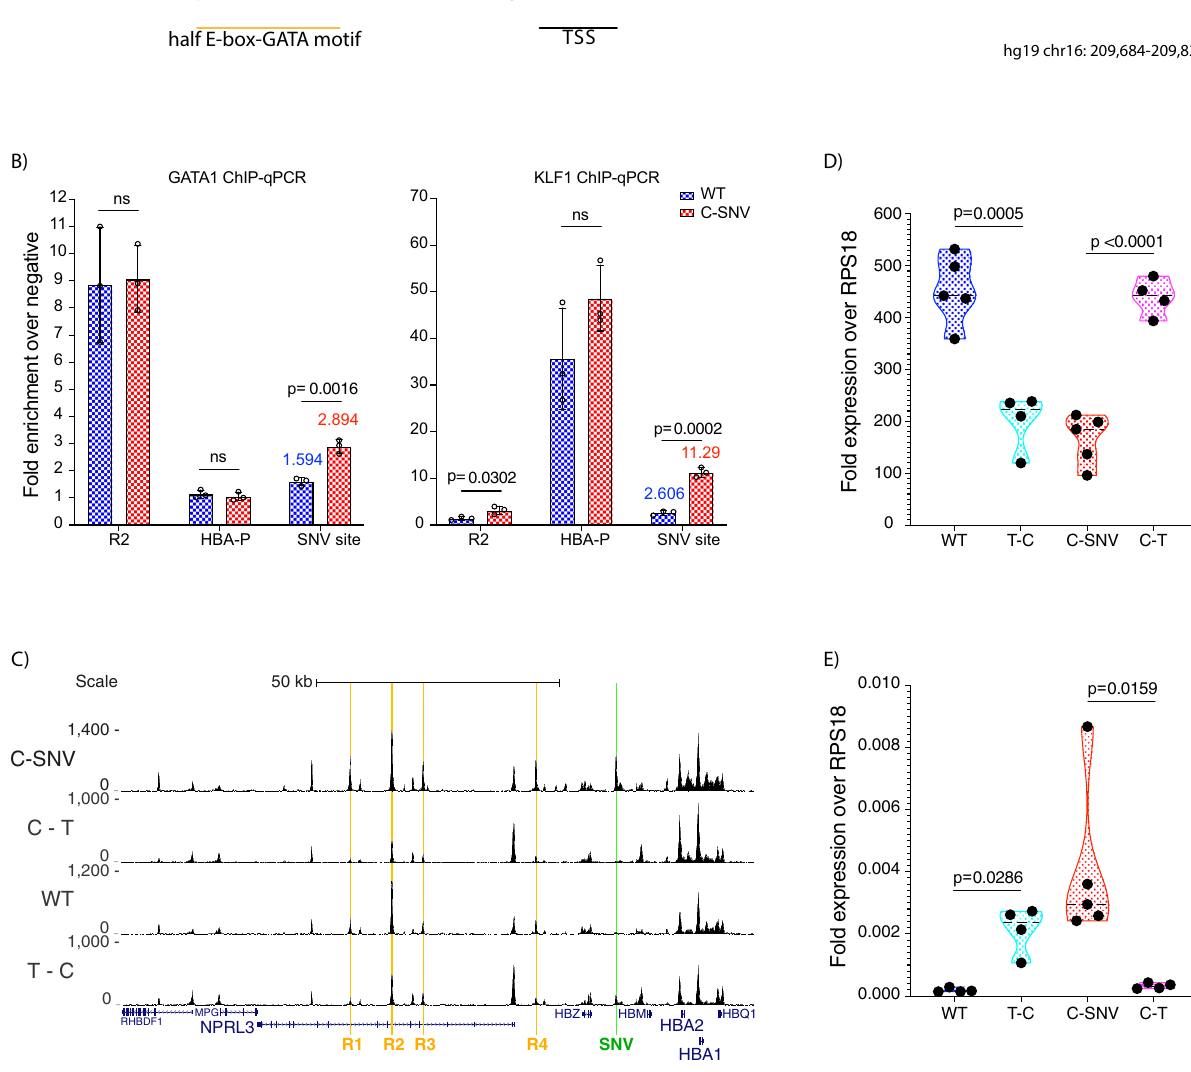
Fig. 2 Point mutation causes the emergence of a de novo promoter. A 138 bp unique sequence around the causative point mutation. The SNV is labelled using the degenerate DNA symbol Y (T/C), key features are highlighted: KLF1 binding site (magenta), GATA1 (red), composite half E-box-GATA motif (orange), core promoter element XCPE1 (blue) and TSS (black). B ChIP-qPCR for GATA1 and KLF1, sequences for TaqMan assays can be found in Supplementary Table 1. Values represent an average of 3 independent experiments, 3 replicates for wild type iPSC line AH017-13 differentiated to erythroblasts (in blue) or 3 C-SNV iPSC clones (in red). Error bars represent one standard deviation. P values are obtained using unpaired, two-tailed student t -test. C Chromatin accessibility by ATAC-seq. The enhancer elements (R1 – R4) are highlighted in orange, the site of the T to C mutation is highlighted in green (SNV), gene annotation by Refseq is in blue. Read-densities represent an average of 3 independent differentiation experiments: wild type iPSC line SB-AD2-01 (labelled WT), 3 C-SNV iPSC clones (labelled C-SNV), 4 clones of edited SB-AD2-01 cells where the T base at position 209,709